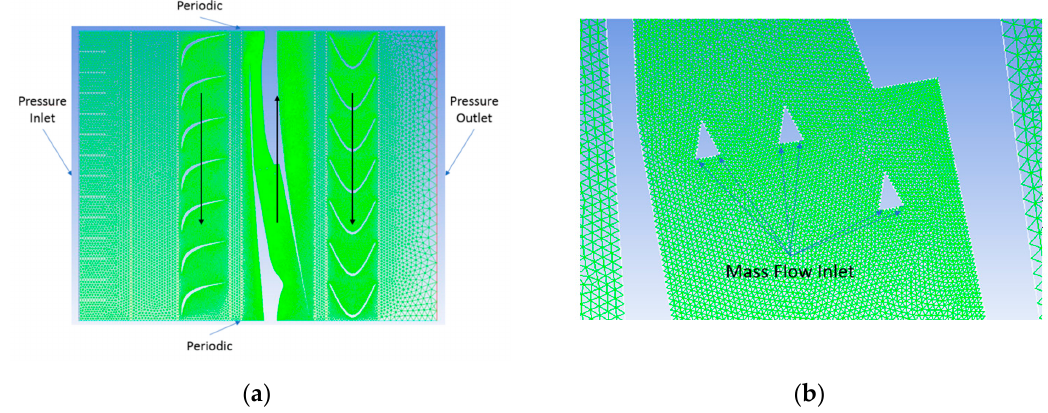
Figure 21. ( a ) Grid used inside the computational domain and the applied boundary conditions. ( b ) Mesh used in the vicinity of the injectors and flame stabilizers, and boundary conditions representing fuel injectors.